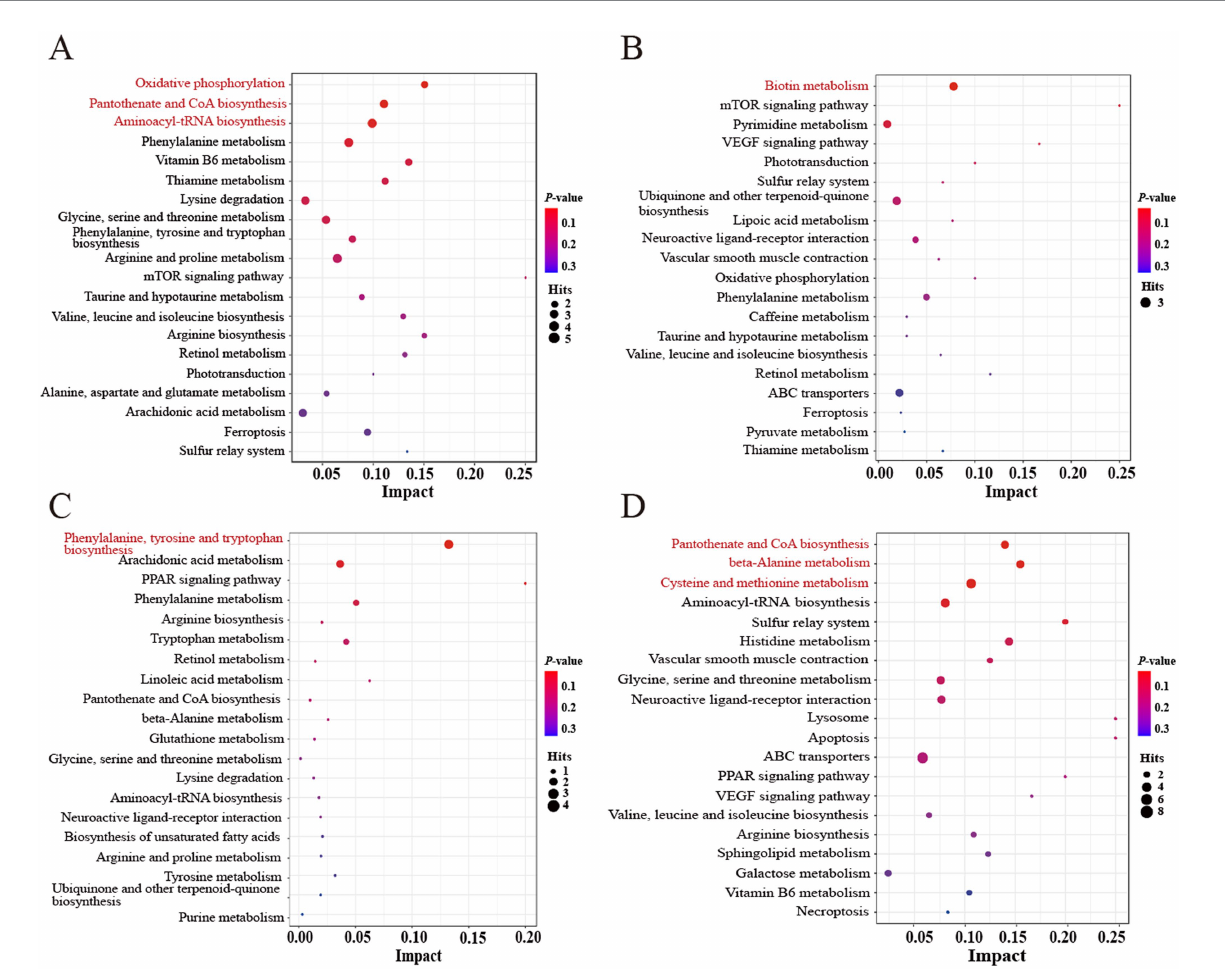
FIGURE 4 Enrichment analysis of differential metabolites in cecal chyme of laying hens. Significantly changed pathways based on enrichment and topology analysis are shown. The X -axis represents pathway impact, and the Y -axis represents pathway enrichment. Larger sizes and darker colors represent higher pathway impact values and higher pathway enrichment, respectively. The red pathway indicates the significantly different metabolic pathways between the two groups. (A) Metabolic pathways between 2.5% HRB and 2.5% FHRB groups. (B) Metabolic pathways between the 5.0% HRB and 5.0% FHRB groups. (C) Metabolic pathways between 2.5% and 5.0% HRB groups. (D) Metabolic pathways between 2.5% and 5.0% FHRB